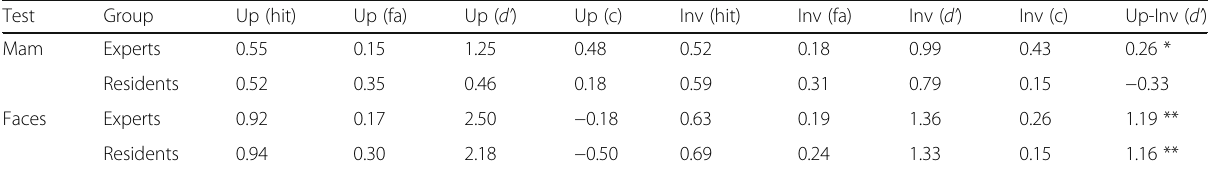
Table 1 Recognition performance of radiology experts and residents for upright and inverted mammogram and face trials in terms of hits ( hit ), false alarms ( fa ), sensitivity ( d ’ ) and bias ( c